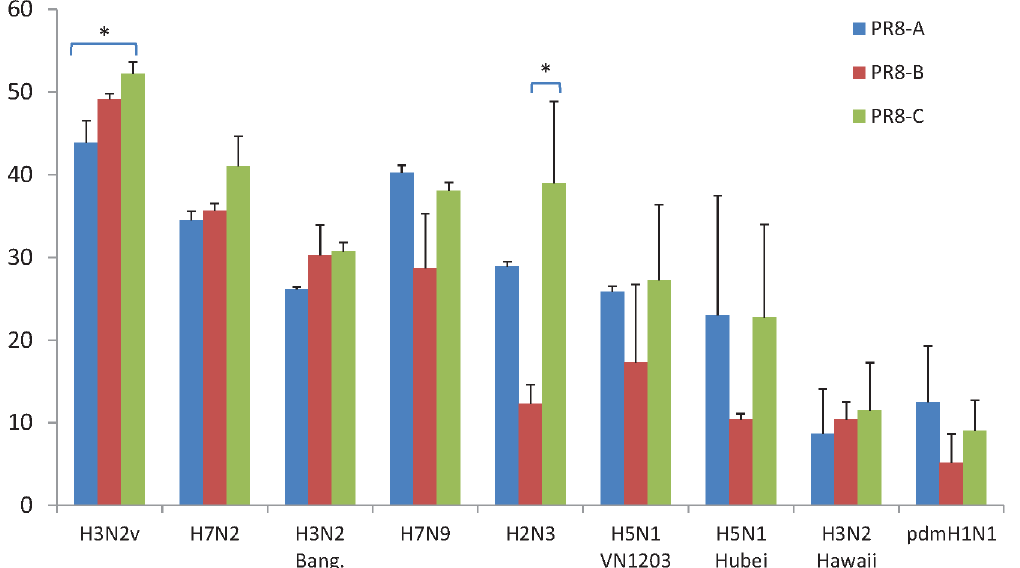
Fig 4. Relative HA content of concentrated virus samples. The relative HA content of each reassortant virus was calculated based on the ratio of the HA (determined by IDMS) to the total protein (determined by BCA). Statistical significance: ( * , P < 0.05; ** , P < 0.01).